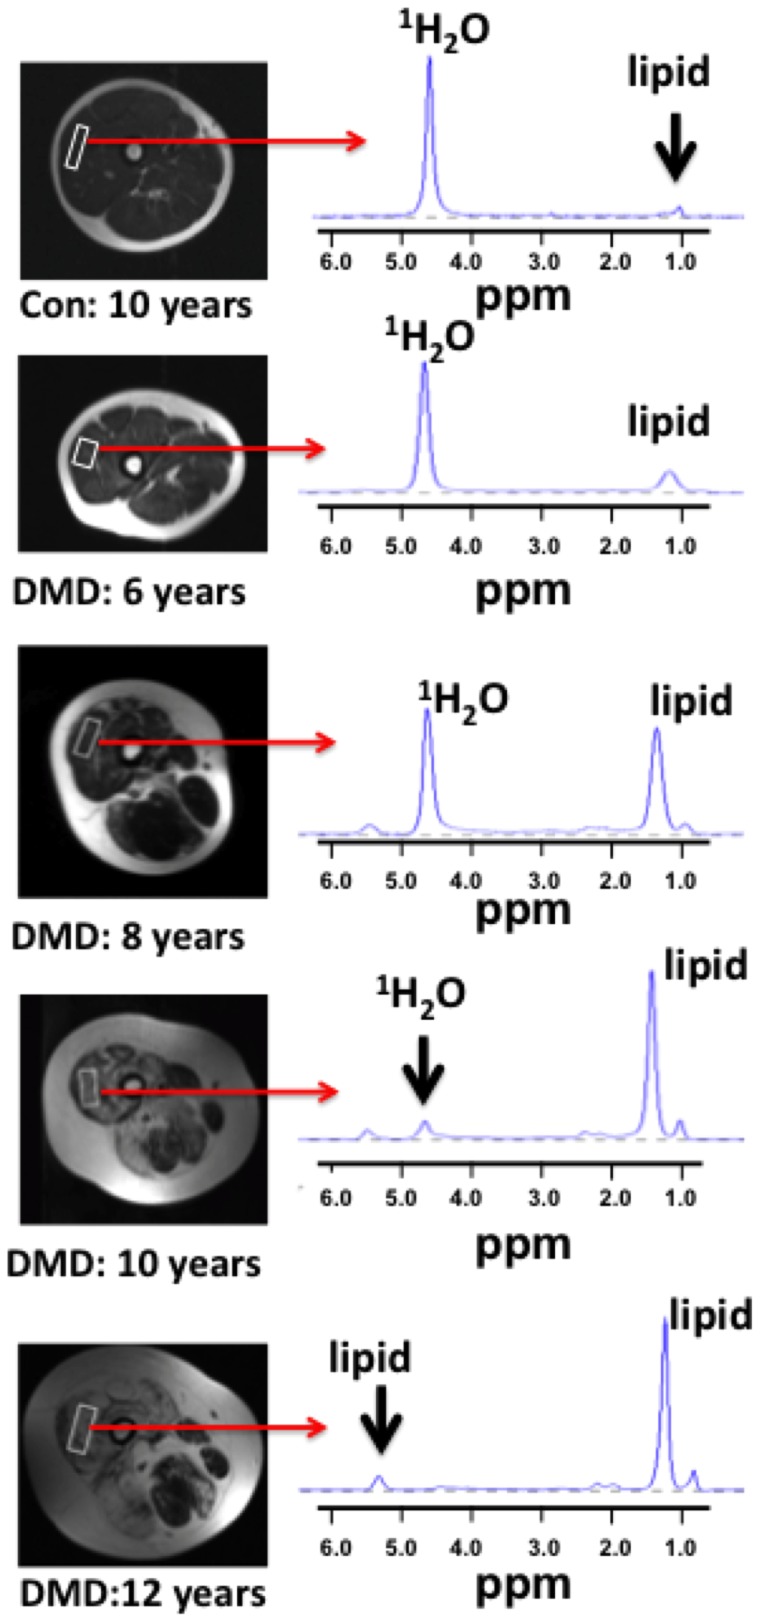
Example upper leg axial spin echo (SE) images (TE 60 ms) with single voxel 1H-MRS spectra (TE 108 ms) from the vastus lateralis of a control and boys with DMD at different ages.